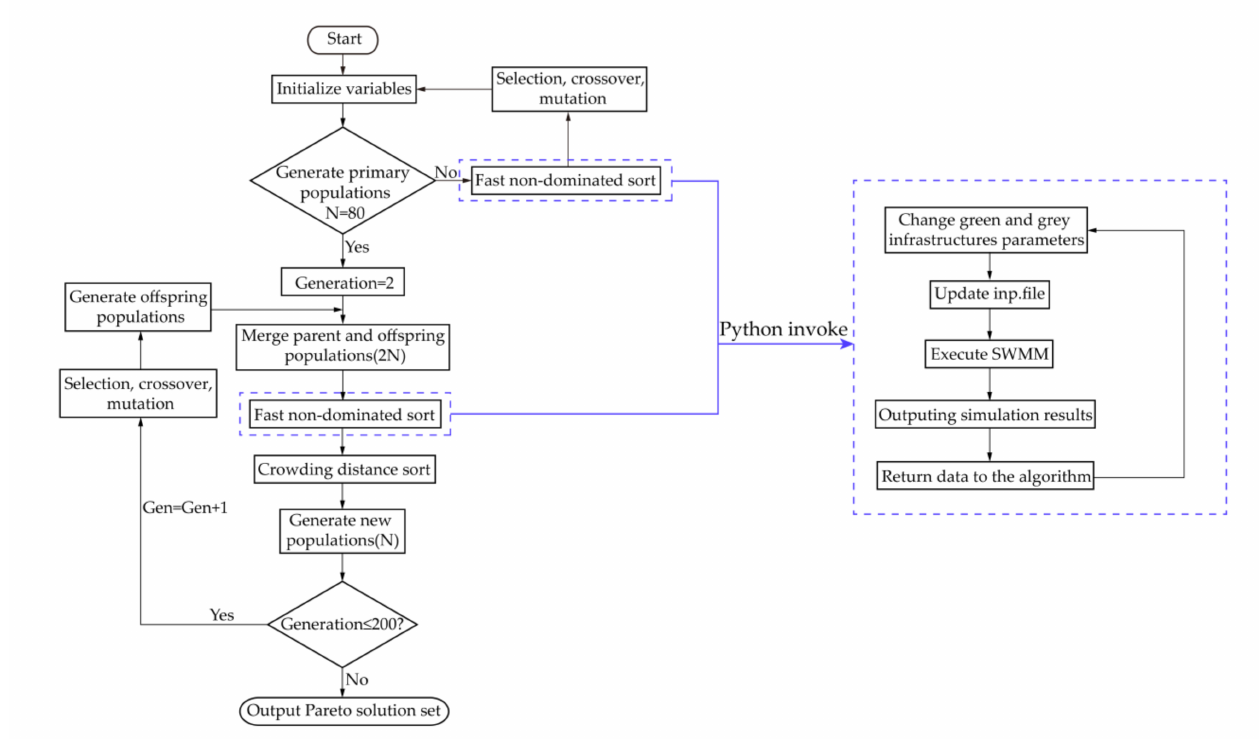
Figure 4. Simulation-optimization framework integrated by NSGA-II and